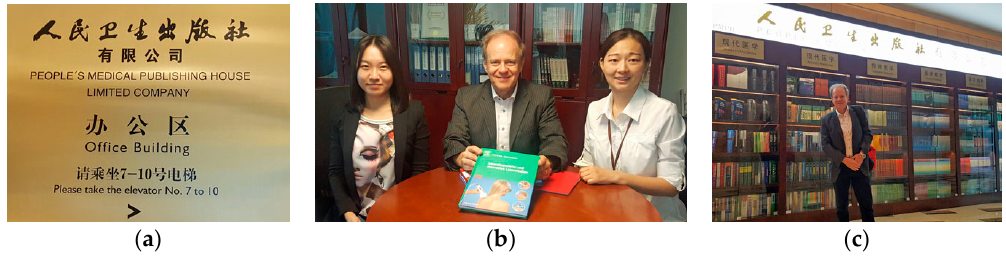
Figure 24. People’s Medical Publishing House ( a – c ). ( b ) From left to right: Cheryl Zhang